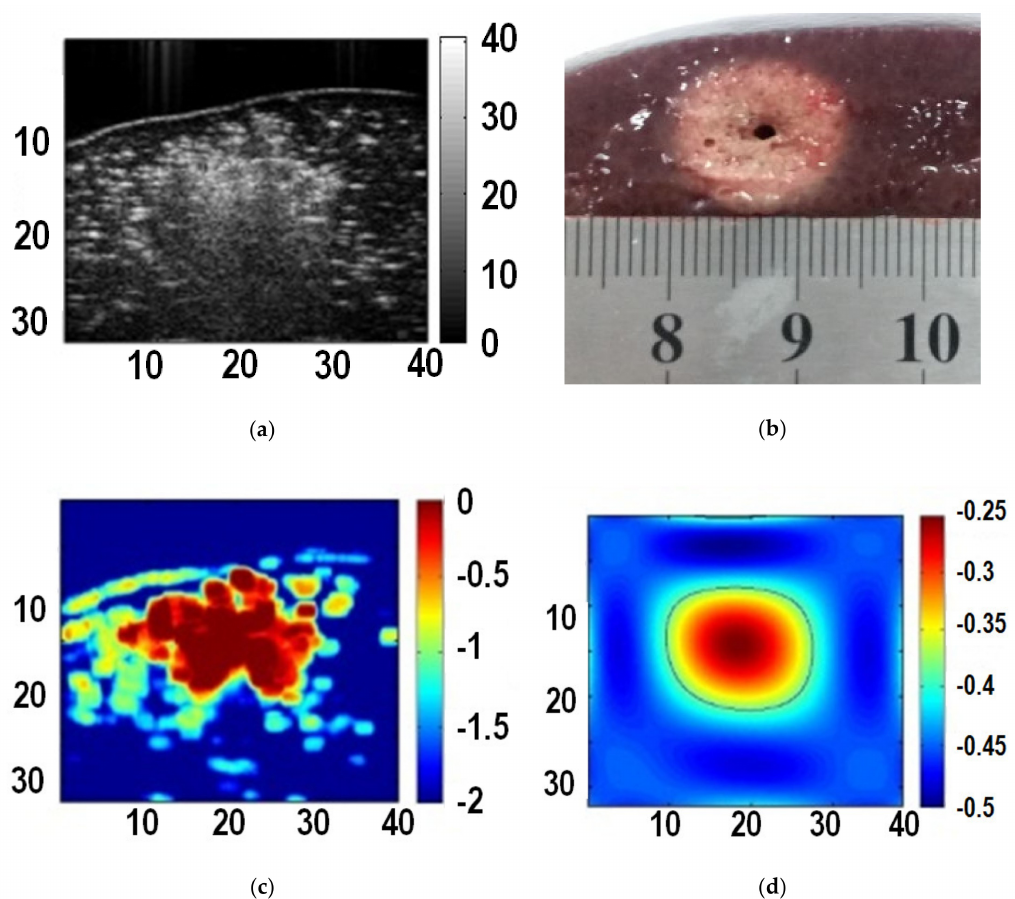
Figure 4. Images of liver tissue at the end of ablation. ( a ) B-mode ultrasound image; ( b ) gross pathology image of the thermal lesion; ( c ) the cumulative echo decorrelation image; ( d ) the polynomial approximation